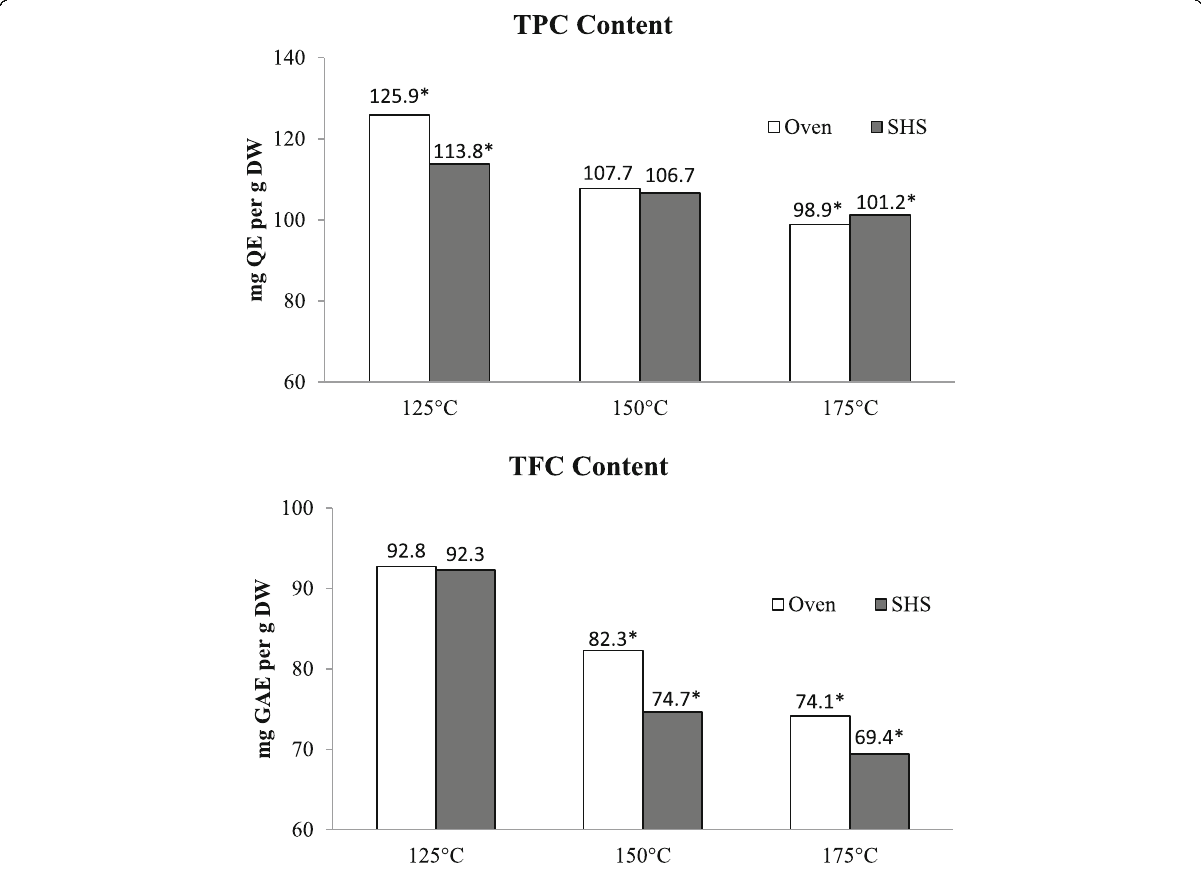
Fig. 3 Comparison of total phenolic and flavonoid contents between oven dried and SHS dried tea leaves at different temperatures. (*) indicates significant differences ( p < 0.05) between values at the same temperature based on independent sample t-test. (SHS = Superheated